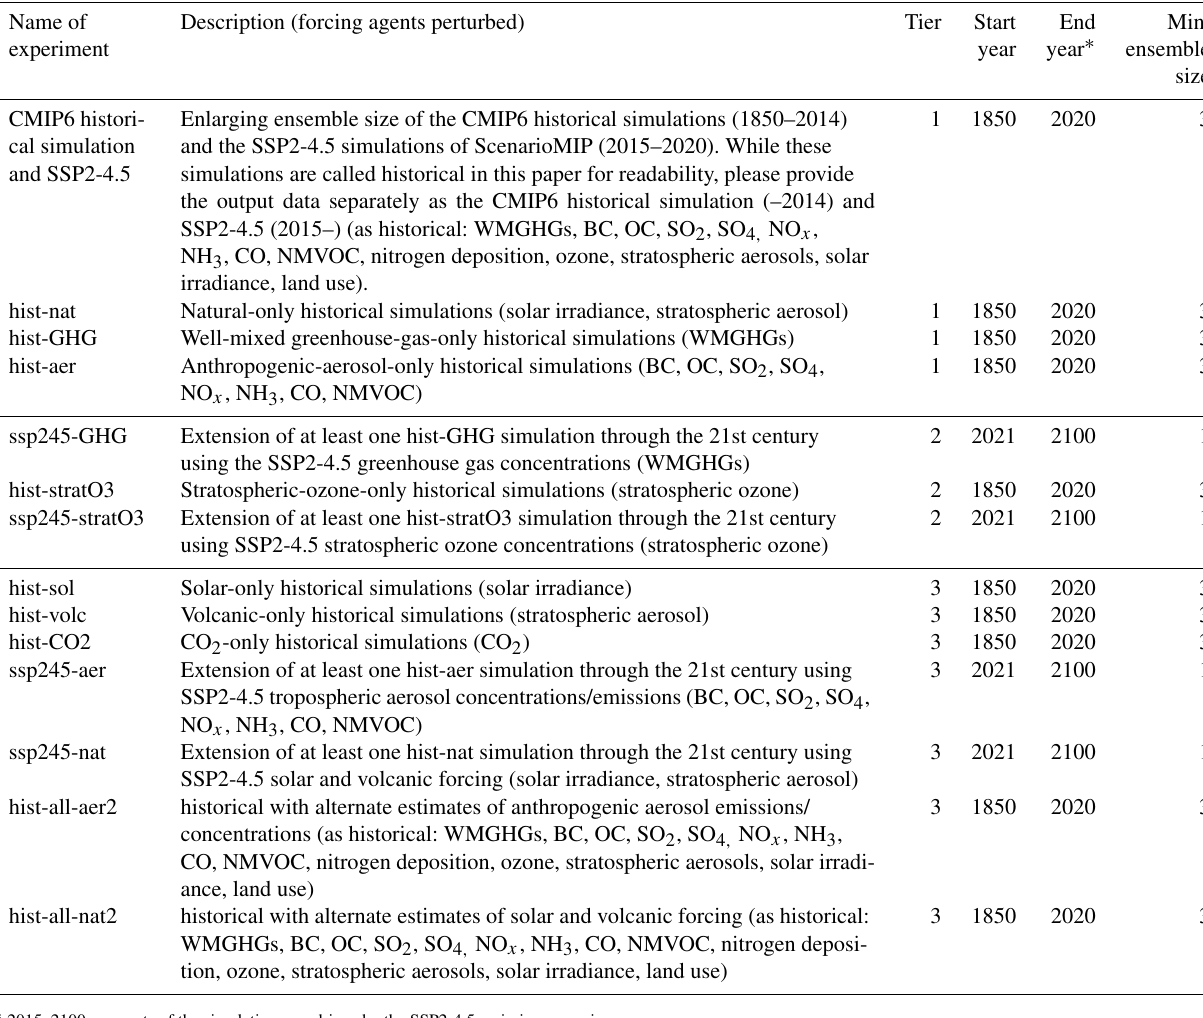
Table 1. List of proposed DAMIP experiments.